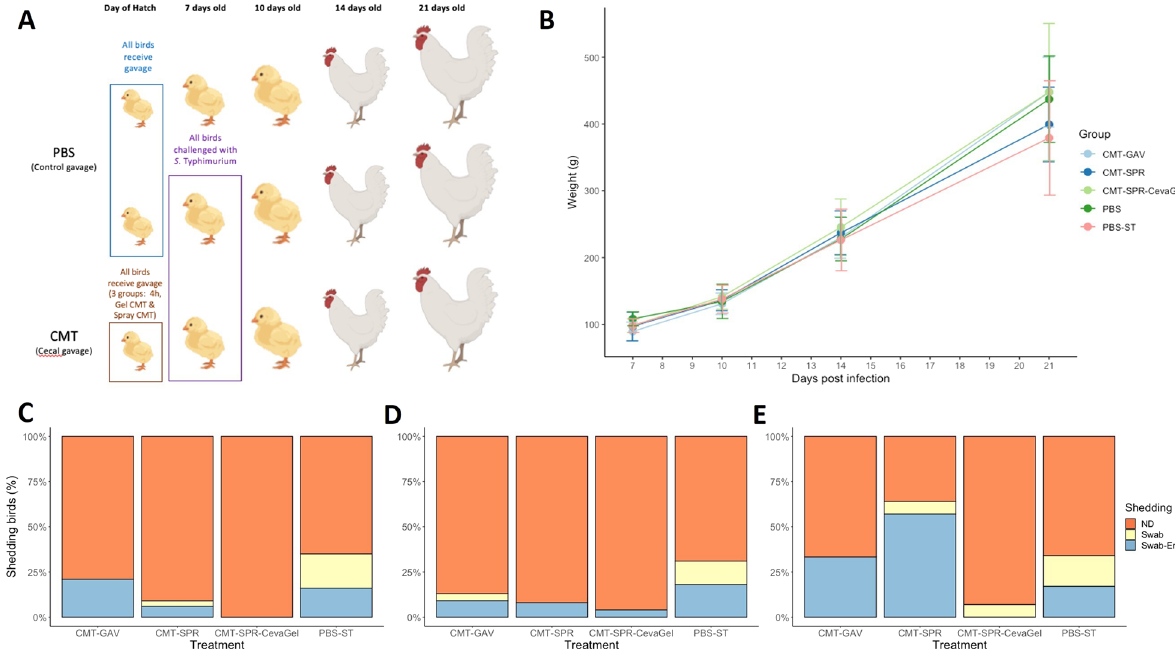
Fig. 3 Route effect study design, bird weights and ST4/74 shedding results. A schematic of the transplant study showing birds given oral gavage of PBS at day of hatch and oral gavage of CMT within 4 h of hatch. Two groups of birds were given transplant in the form of spray delivery (CMT-SPR) or gel spray (CMT-SPR-CevaGel) delivery within 24 h of hatch. Time points show procedures carried out on groups; at 7 days old ST4/74 was given to one PBS group and all CMT groups with ~ 10 birds from each group killed for post-mortem analysis and collection of cecal content for 16S rRNA analysis. At 10-, 14- and 21-days old a subset of birds from each group were killed for post-mortem analysis and sample collection. All birds in each group were swabbed at 3-, 7-, 10- and 14-dpi to assess faecal shedding of ST4/74. Schematic produced using Biorender. B All birds in each group were weighed at 3-, 7-, 14- and 21-days of age. There were no significant differences between groups on the average weight of birds. C - E Results of faecal shedding of ST4/74 at 3-, 7-, and 14-dpi as measured by cloacal swabbing and plating on to Salmonella selective agar. Shedding was recorded as no shedding (ND (Non-Detected), orange), ST4/74 detected following enrichment of swab (Swab-Enr, blue) and ST4/74 detected straight from swab onto plate (Swab, yellow). Compared to PBS treated groups, CMT treated groups were shown to have less faecal shedding of Salmonella throughout the experimental